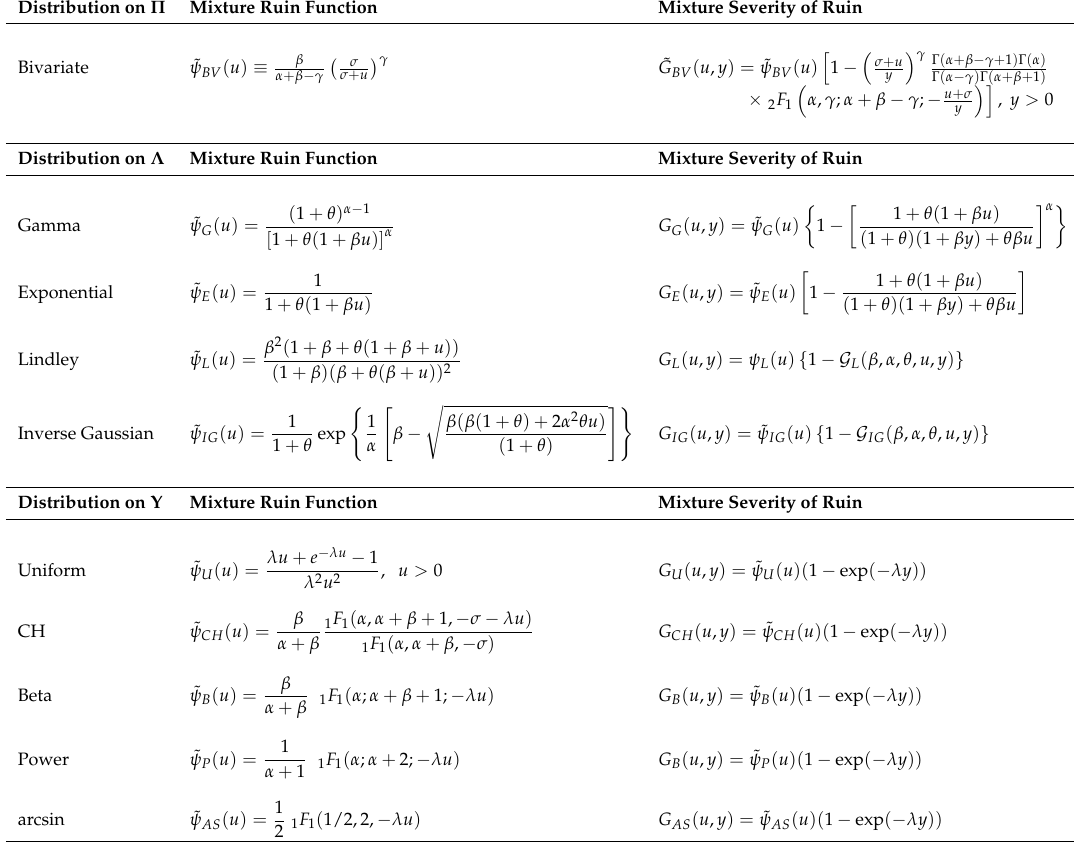
Table 1. Specific examples of mixture ruin probability functions and mixture severity of